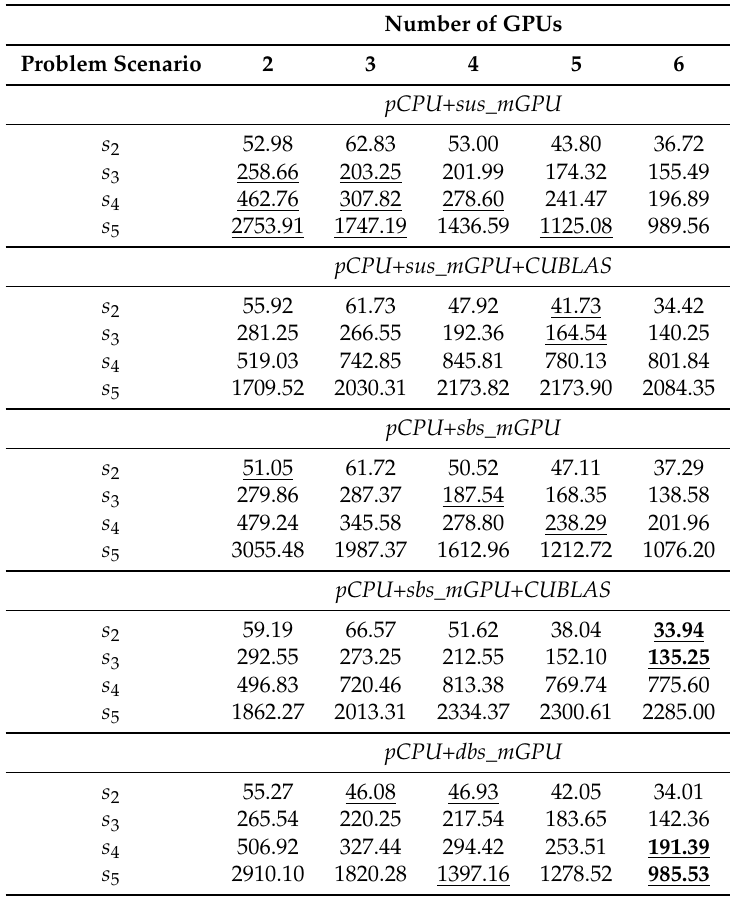
Table 5. Execution times of different hybrid versions (CPU plus multiple GPUs), for different problem scenarios (Table 1) and varying the number of GPUs, in jupiter, for 10 iterations, in